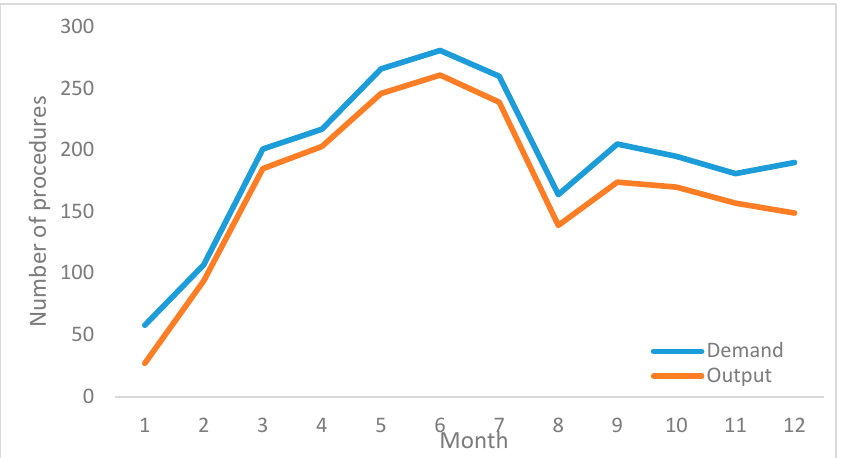
Figure 4. Monthly demand and output of procedures in the angiography room.